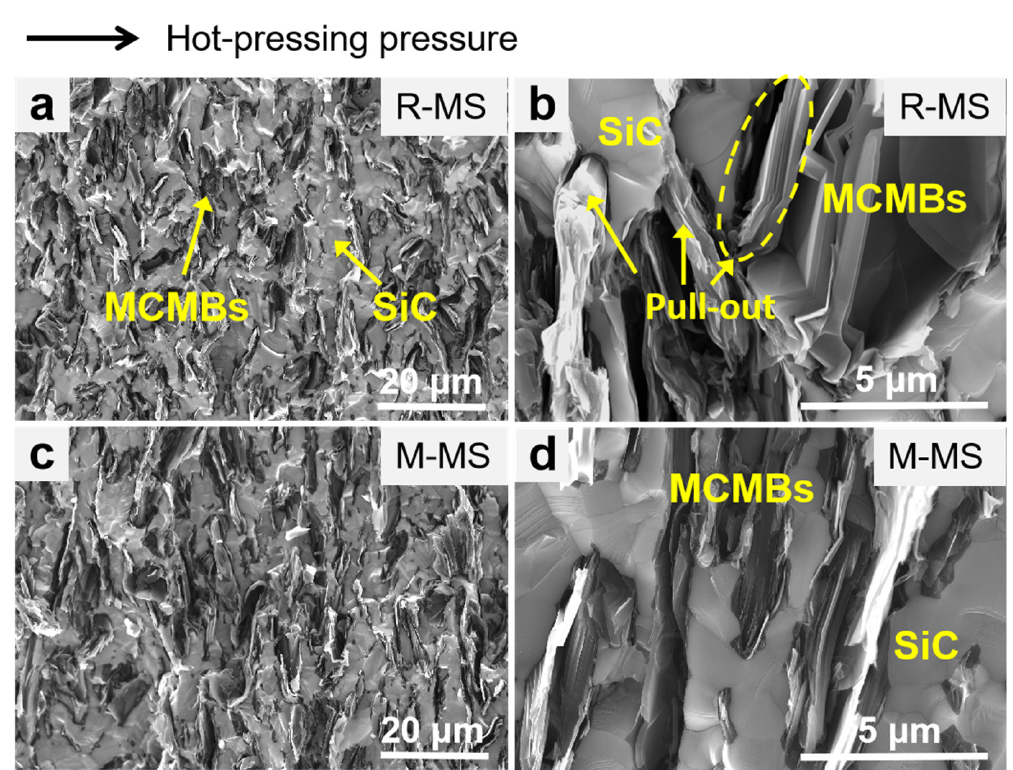
Figure 5. SEM images of cross-sectional of MCMB-SiC composites: ( a , b ) R-MS; ( c , d ) M-MS. The relative density and mechanical properties of two MCMB-SiC self-lubricating composites are listed in Table 2.